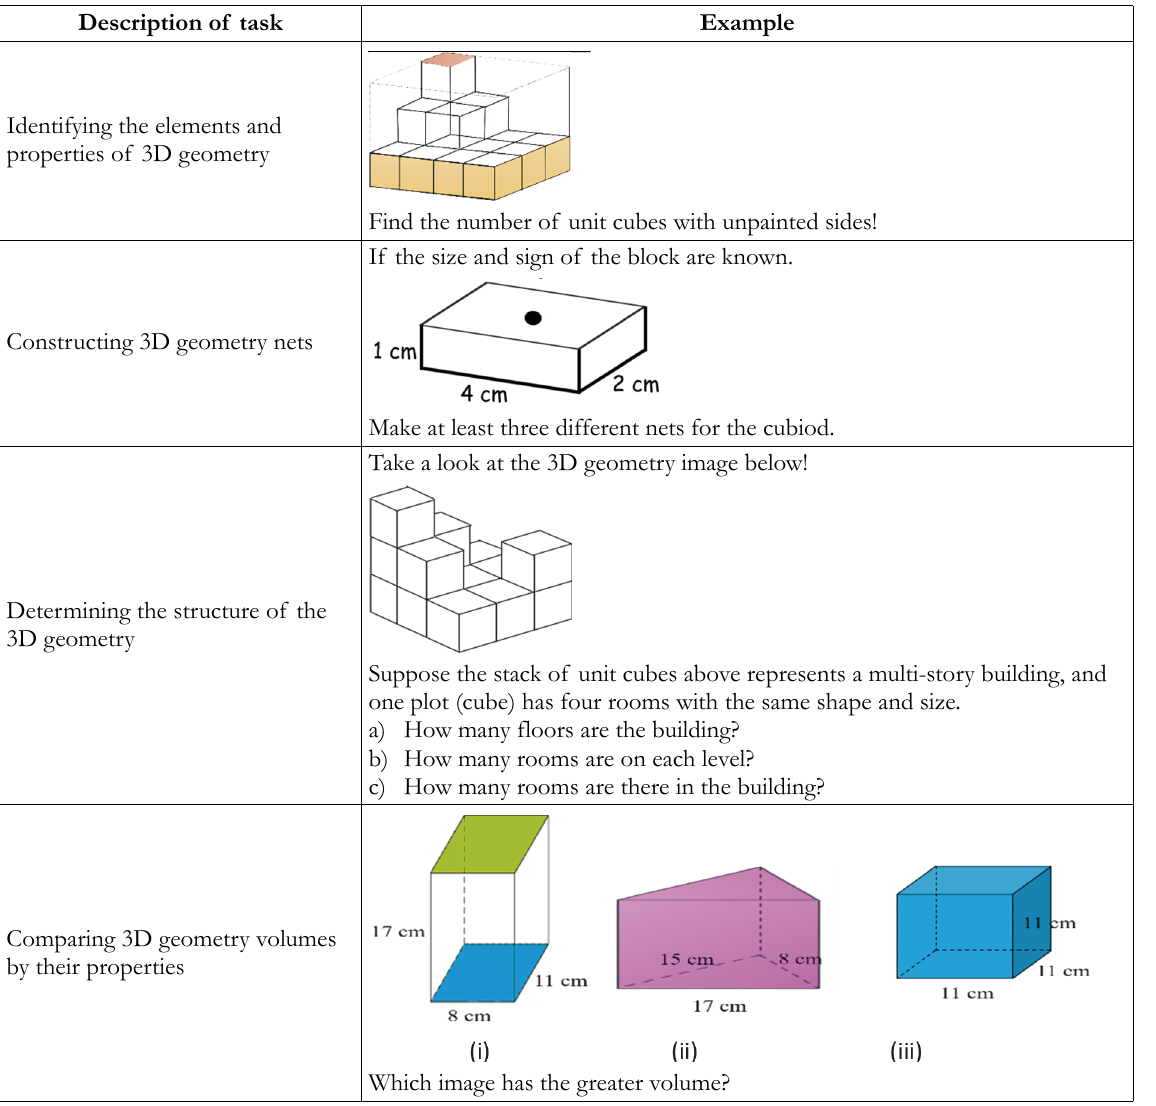
Table 4. Description of